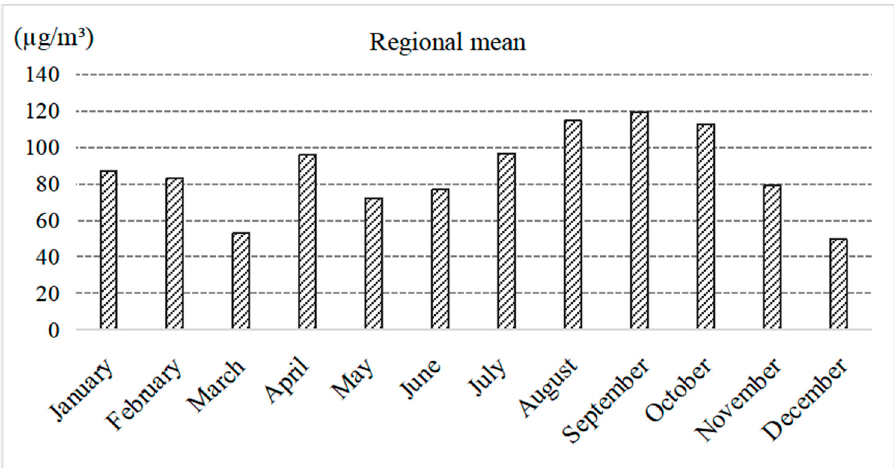
Figure 3. Monthly means of ozone concentration in the Pearl River Delta Metropolitan Region.